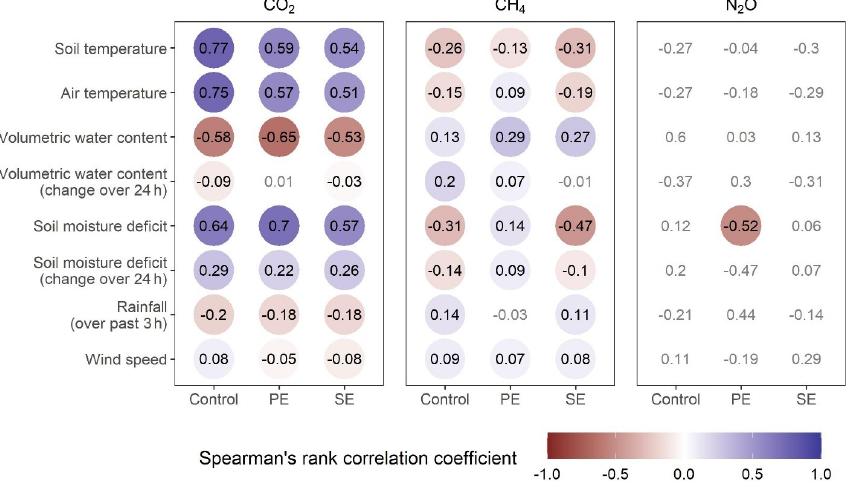
Figure 5. Correlograms of observed fluxes over the STU for CO 2 , CH 4 and N 2 O to selected environmental parameters. The numerical value and fill colour correspond to Spearman’s rank correlation coefficient where the correlation was significant (i.e. p ≤ 0.05). Grey numerical values without coloured circles represent correlations that were not significantly different from zero (i.e. p >